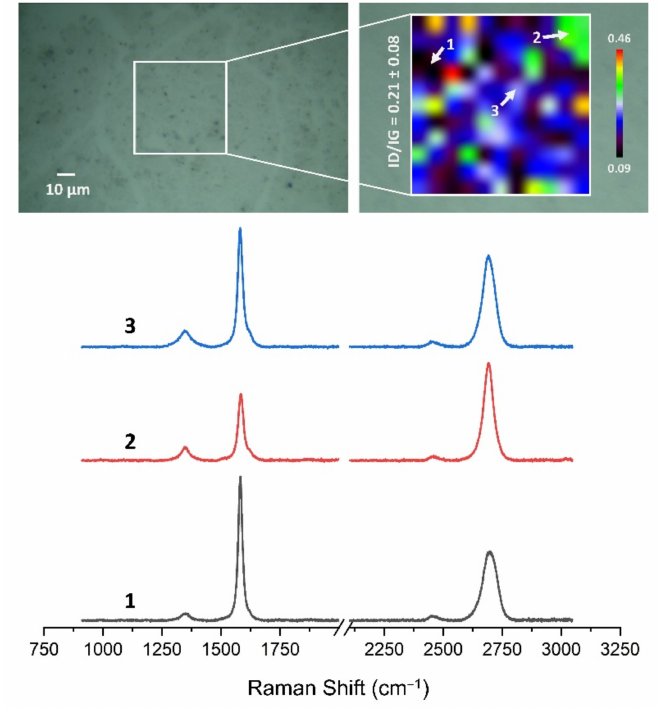
Figure 16. The Raman map and spectra of CVD graphene transferred onto Al 2 O 3 ceramic substrates modified by DBD